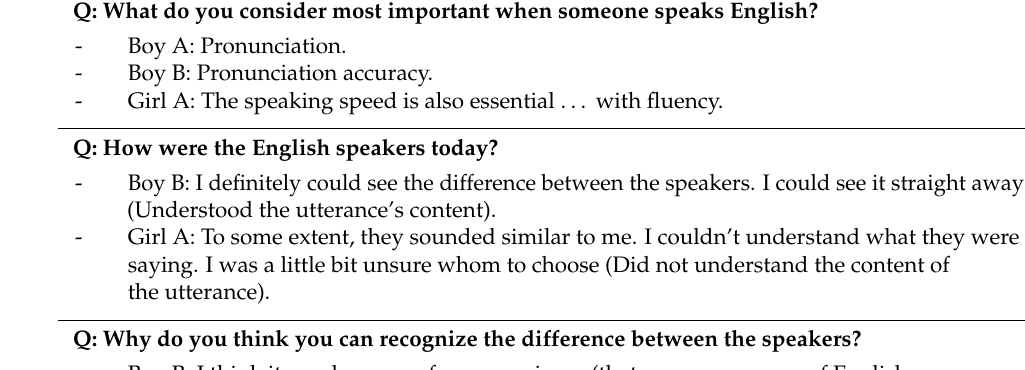
Table 6. 12-year-old responses to the five additional